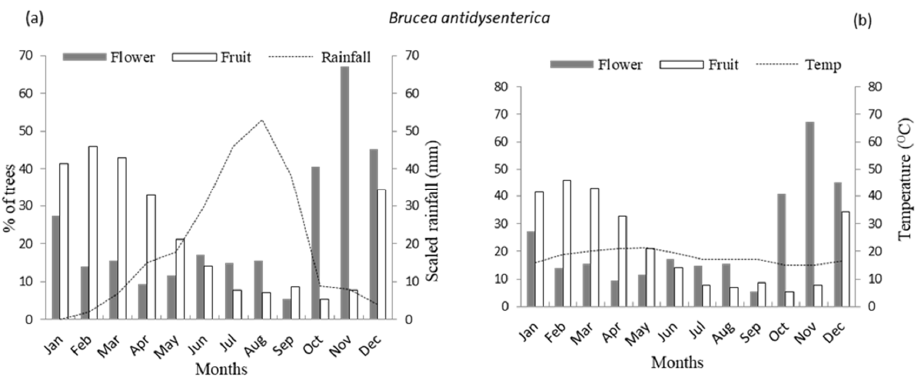
Figure 2. Percentage of flowering and fruiting of Bersama abyssinica in relation to: ( a ) monthly precipitation ( b ) average temperature. In which Jan = January, Feb = February, Mar = March, Apr = April, May = May, Jun = June, Jul = July, Aug = August, Sep = September, Oct = October, Nov = November, Dec = December.